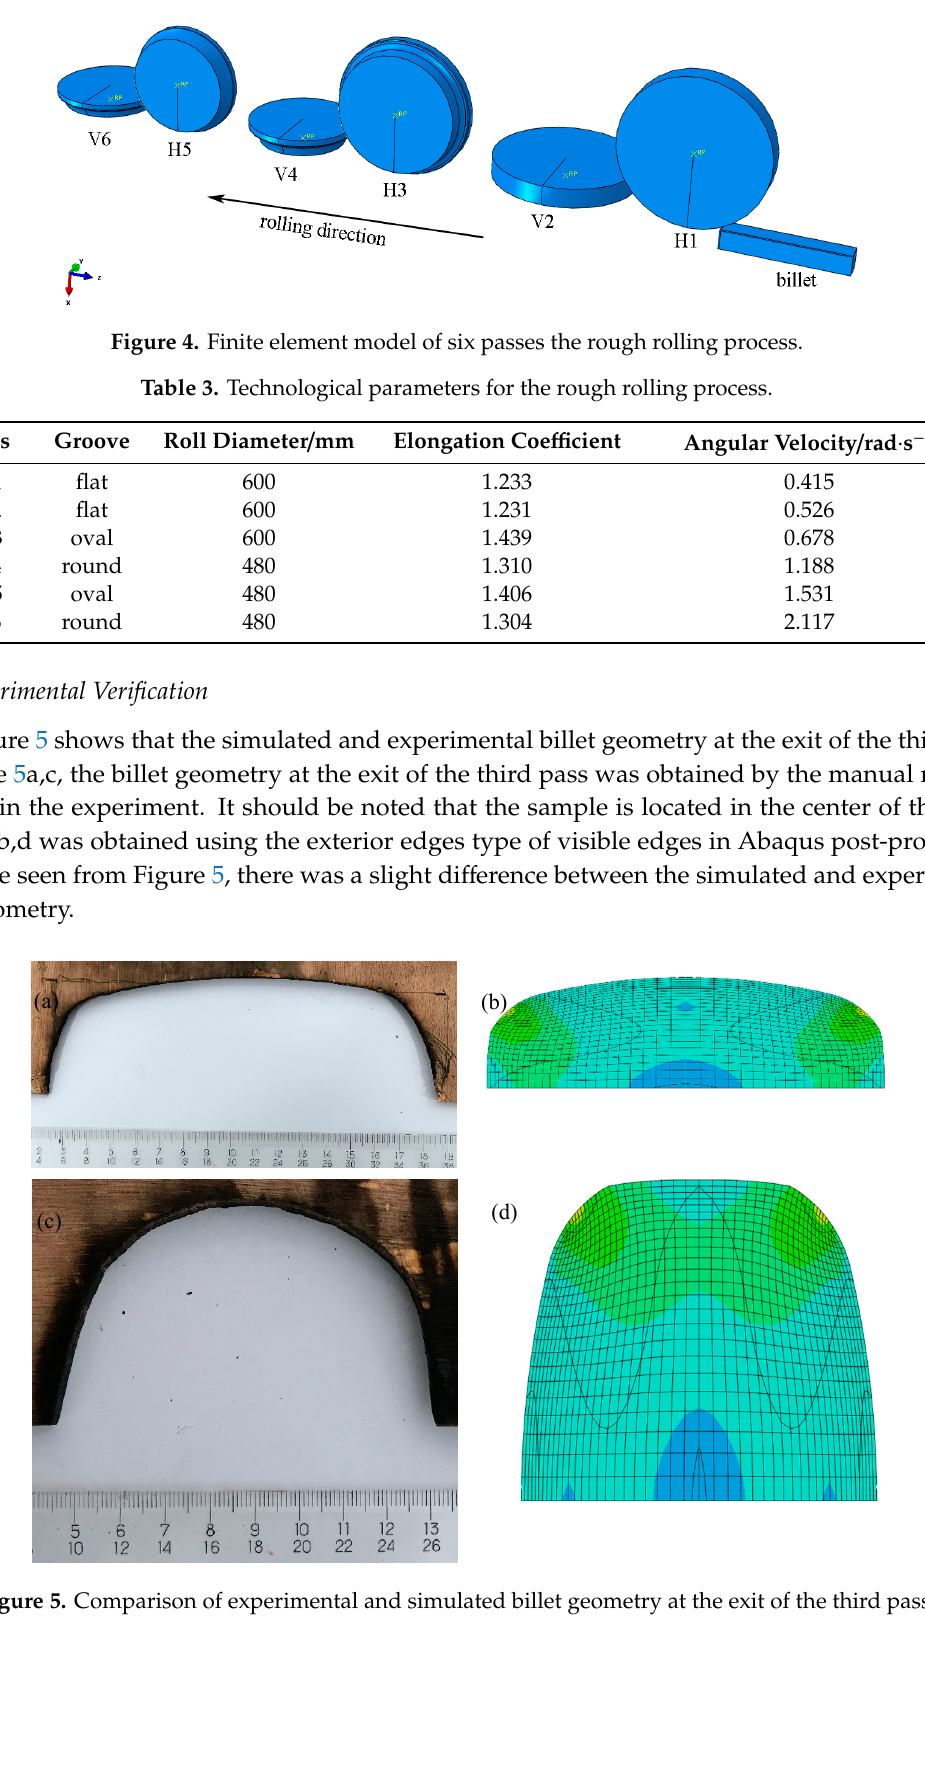
Figure 6. Comparison of experimental and simulated billet sizes at exit of each pass. 3. Results and Discussion 3.1. Analysis of Hot Bar Rolling Deformation As shown in Figure 7, the effective plastic strain, effective stress and temperature distribution of billet at the exit of the third pass of rough rolling were instigated with the finite element simulations. Compared to other areas, the maximum of equivalent von Mises stress and the total equivalent plastic strain of the fillet corner were greater. However, the surface temperature of billet was much lower than the center area. In Figure 8, point A and B were chosen to investigate the temperature change, which were located at the center and fillet edge of the billet respectively. Before rolling, the temperature of Point B dropped slowly due to air convection. When the roll contacted with the billet, it dropped rapidly because the roll temperature was lower than the billet during the rolling deformation. After rolling, the surface temperature gradually recovered due to heat transfer from center area to the surface. However, the temperature of Point A rose due to heat generation of plastic